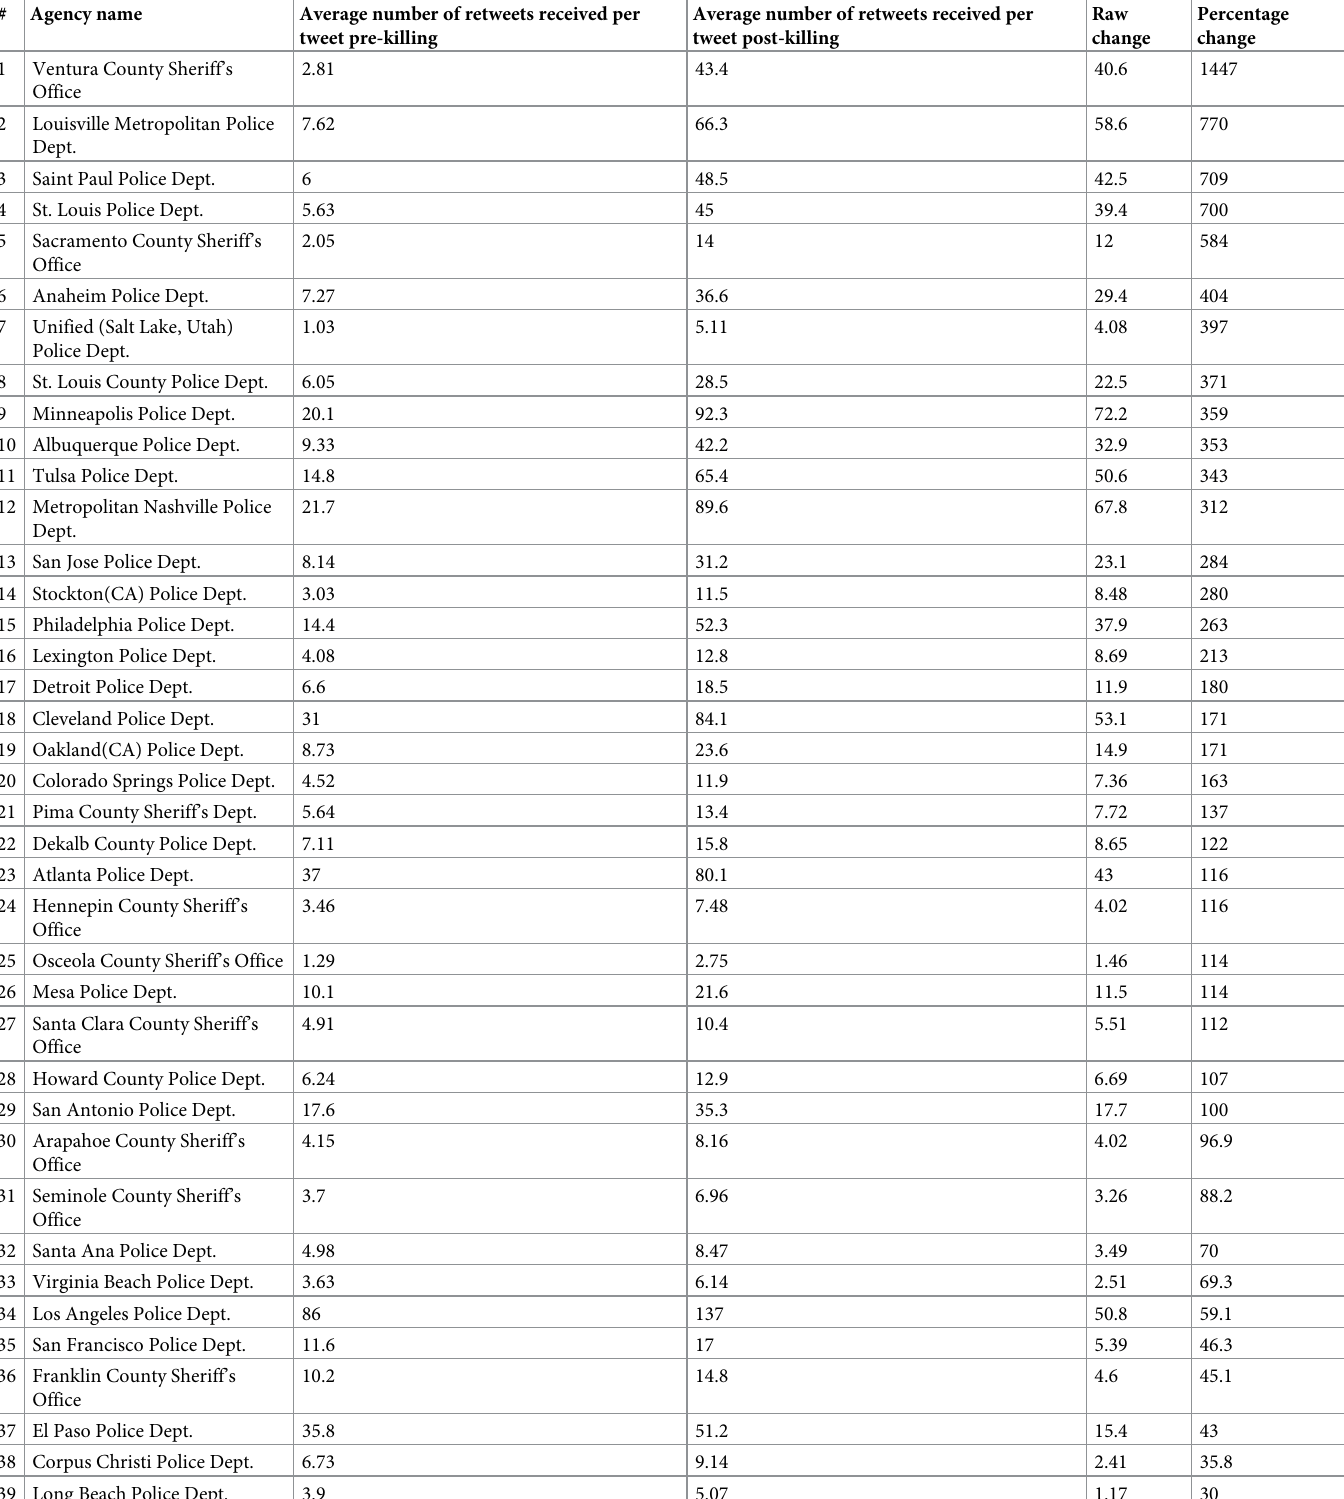
Table 8. Agencies (in the lower-use group) ranked by the increase in the received retweets per tweet before and after the killing. # Agency